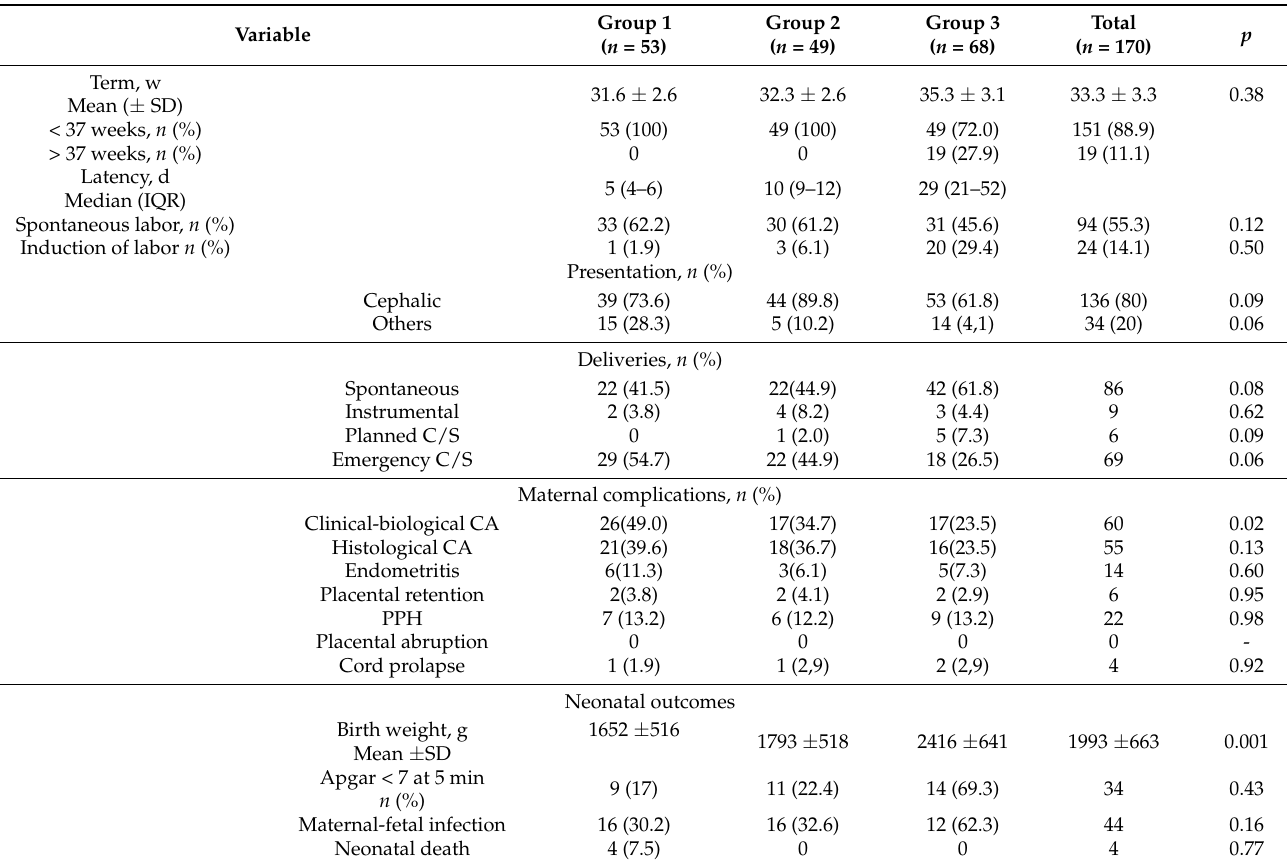
Table 5. Delivery modalities and neonatal outcomes.